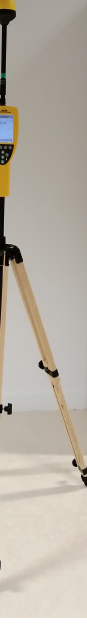
Figure 2. Narda NBM-550 broadband measurement